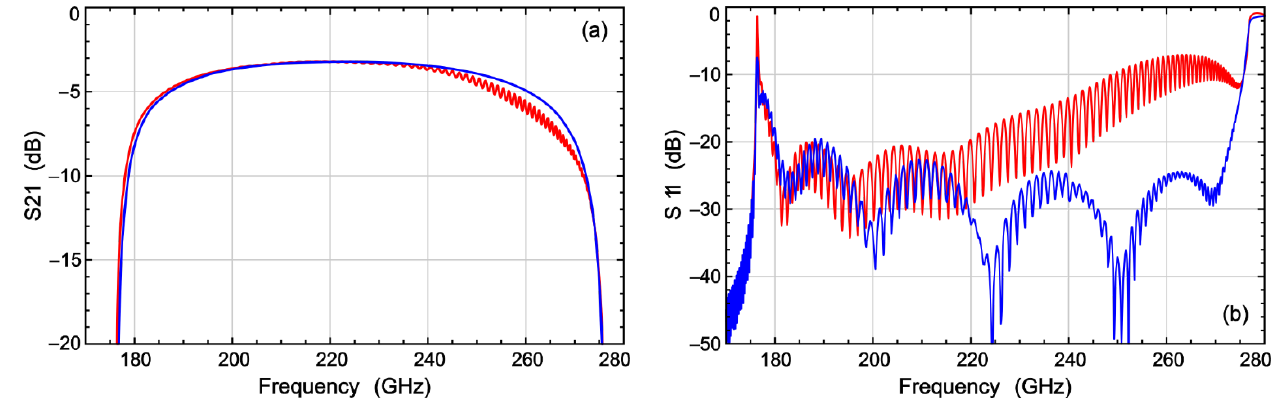
Figure 6. ( a )Transmission loss and ( b ) reflection loss of the complete structure consisting of 50 DSG SWS periods for the initial (red lines) and improved (blue lines) designs of the input/output tapers shown in Figure 4.